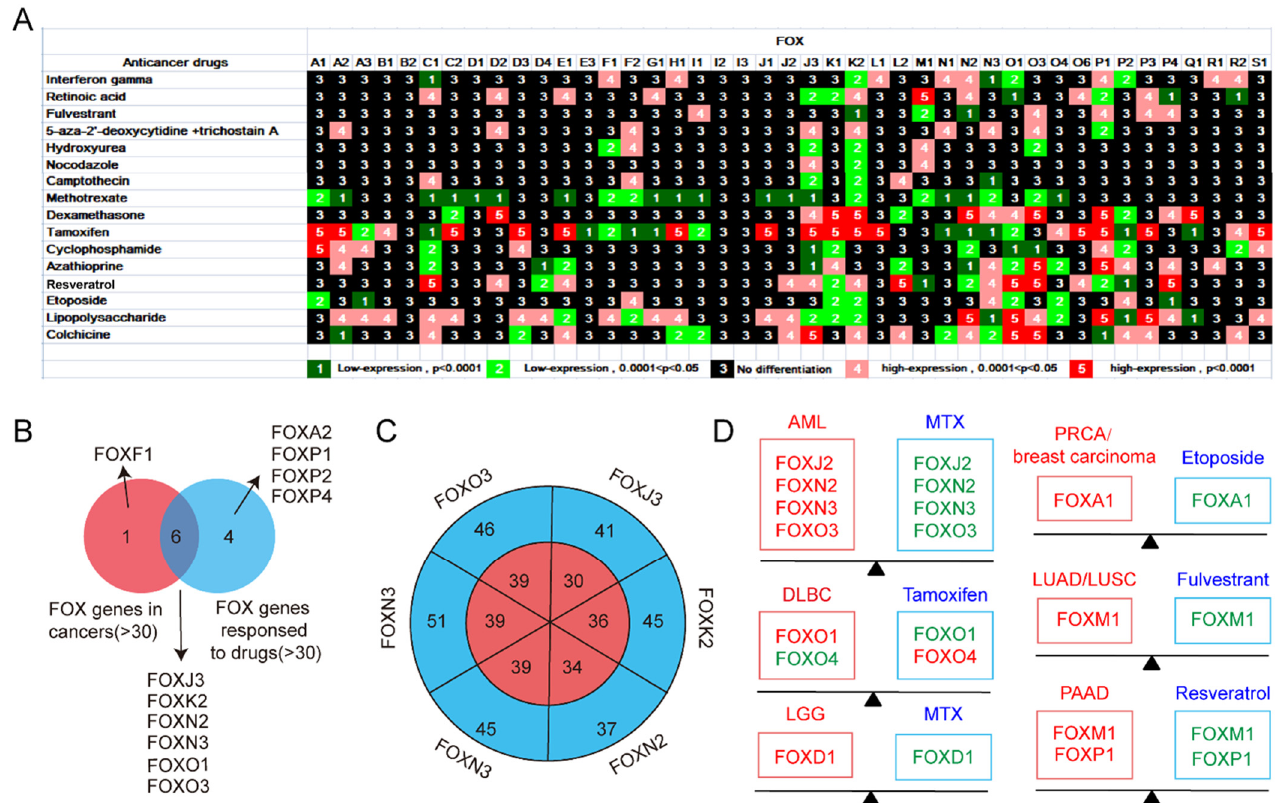
Figure 8. Differential expression of FOX genes response to anticancer drugs ( A ). ( B ) Statistics of FOX genes differentially expressed in various tumors (>30) and sensitive to multiple chemotherapeutic agents (>30). ( C ) The corresponding numbers of tumors (in the red circle) and chemical substances (in the blue circle) of six FOX genes. ( D ) The potential therapeutic roles of anticancer drugs to certain tumors due to opposing regulatory effects on the same FOX genes.